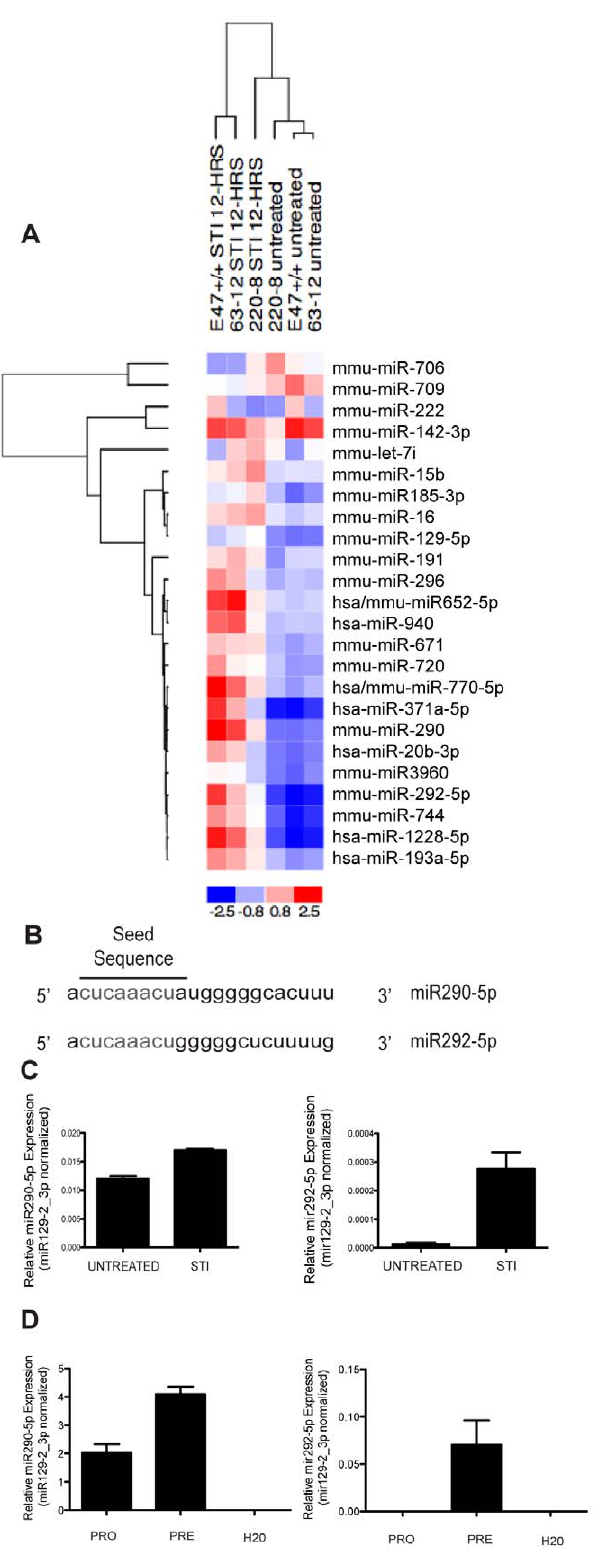
Figure 1. miR290-5p and miR292-5p are induced at the pro-B to pre-B transition. 1A. Heat-map representing levels of miRNAs from a microarray analysis of RNA purified from the indicated AMuLV cell lines cultured in the absence or presence of STI571 (2.5 m M, 12 hr). Performed once in three independently transformed cell lines. 1B.